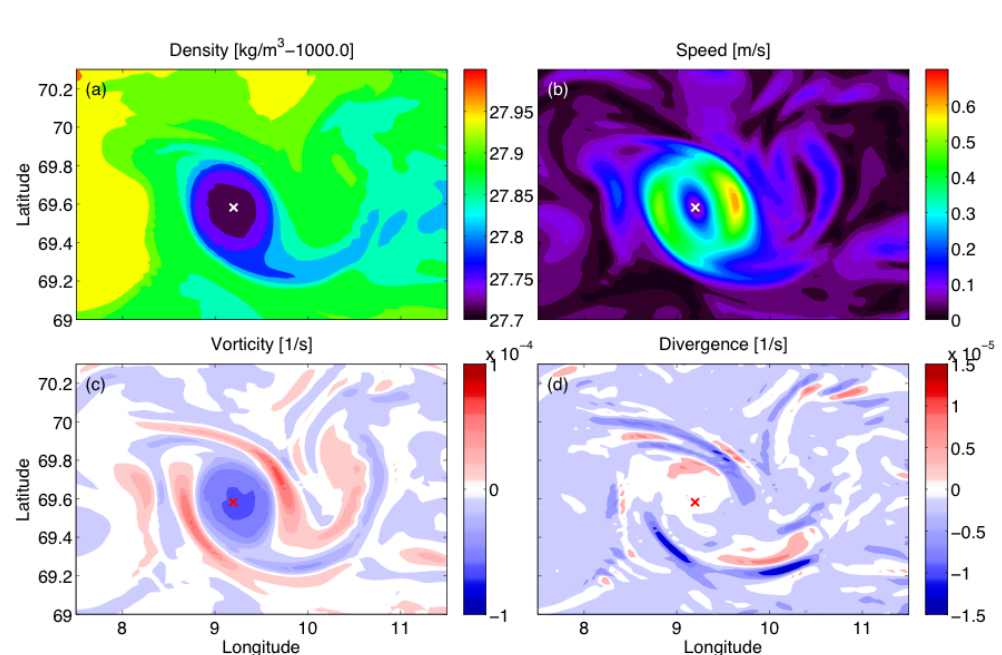
Fig. 2. The physical properties of the eddy. The eddy is almost circular with a small “tail” and, being an anticyclone, has lower density at the center (a) . The maximum speed is found around the rim (b) , and in the same area the boundary between the core with negative vorticity and the outer part with positive vorticity is found (c) . The divergence field (d) is strongest in the outer part of the eddy where there is strong convergence, in addition we find an area with convergence adjacent to an area with divergence in the “tail”. All field have been taken from layer 5 (from 16 to 21m) of the model on 31 March 1999. The eddy center has been marked with an